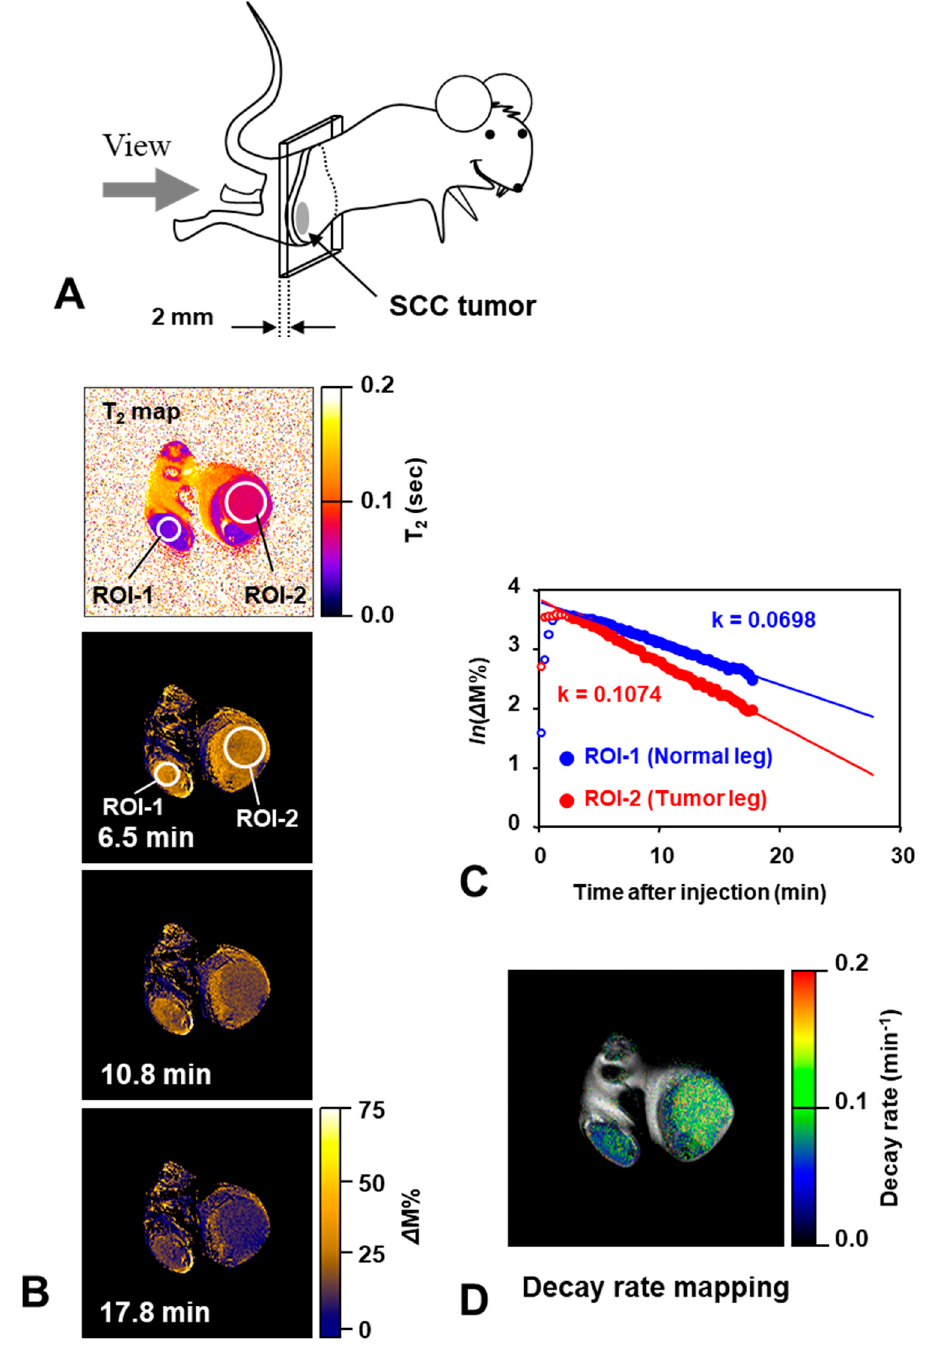
Figure 10. An example of MR-based redox imaging. ( A ) Direction of the slice view of MRI with respect to the subjected mouse. ( B ) Time course of Δ M% signal of T 1 -weighted MRI and a scout T 2 -mapping for ROI selection. Time after injection was indicated in each image. ROI-1 for normal leg and ROI-2 for tumor leg were estimated based on a previously obtained T 2 -mapping. Field of view was 3.2 × 3.2 cm. ( C ) Time course of average Δ M% signal in the ROI-1 and ROI-2. Logarithmic values of Δ M% signal in the ROIs are plotted with time. Decay rate constants were obtained from the slope of linear decay after peak. ( D ) Decay rate map overlapped on the corresponding multi-slice-multi-echo image can show a distribution of decay rates with clear anatomic information. The figure was partly modified from our previous report [102].